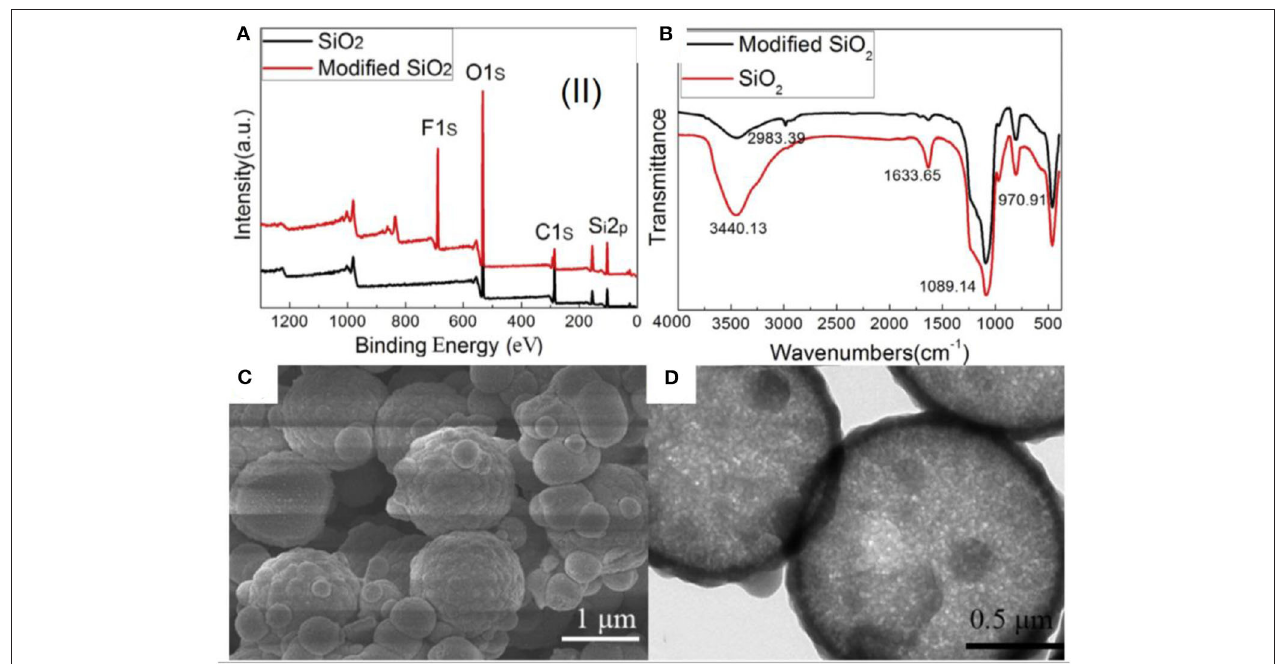
FIGURE 4 | (A) X-ray photoelectron spectroscopy (XPS) spectra and (B) Fourier transform infrared (FTIR) spectra of silica before and after modification. (C,D) Scanning electron microscopy (SEM) and transmission electron microscopy (TEM) images of superhydrophobic silica microspheres. Adapted from Guo et al. (2017b). With permission from Elsevier, copyright 2017. Figure showing the characterizations of functionalized silica particles prepared by using polystyrene (PS) microspheres as a template.